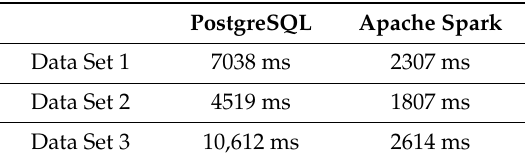
Table 2. Analysis of query performances of the used methods.